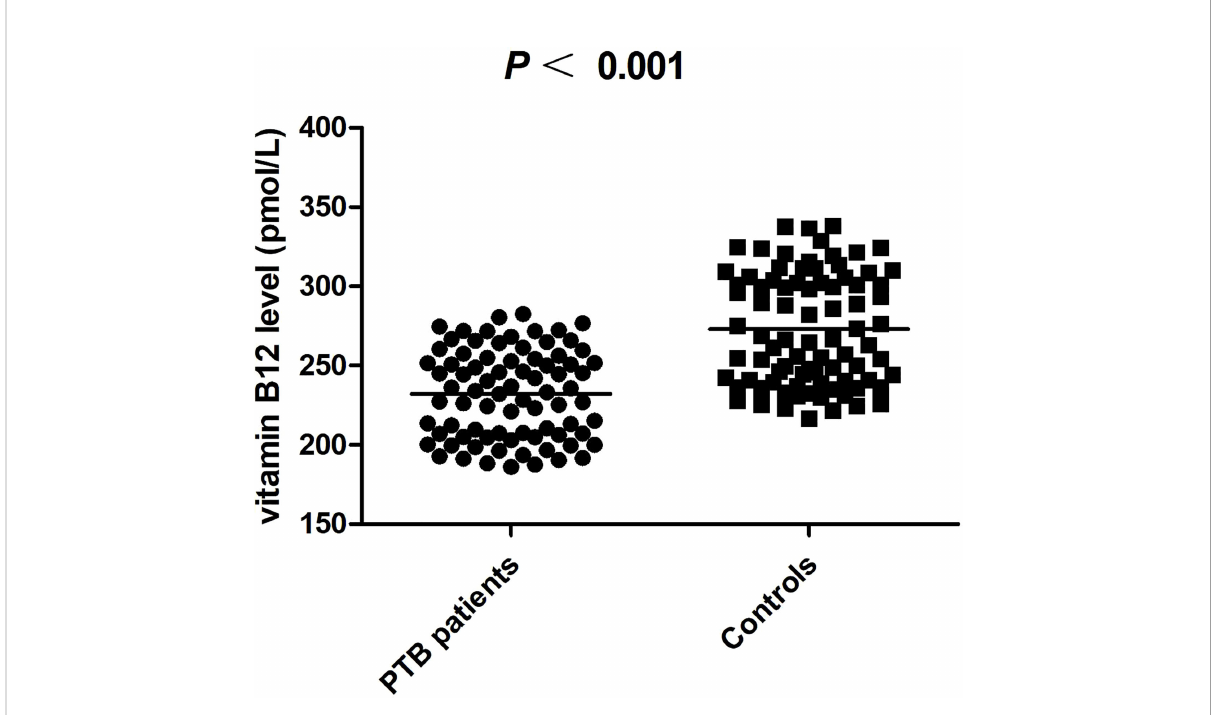
FIGURE 1 The plasma level of vitamin B12 in PTB patients and